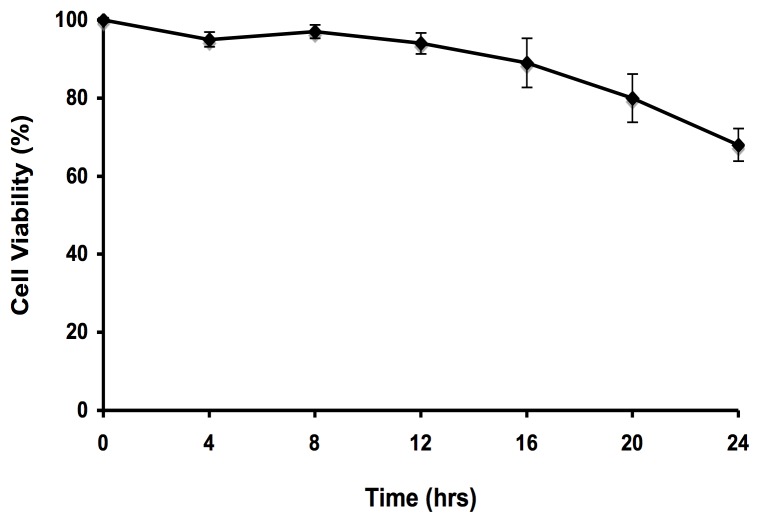
Transcripts altered by iAs exposure.Volcano plots of differential transcripts up- (black dots) and down-regulated (grey dots) after (A) 2 and (B) 12 hrs of exposure to 5 µM of iAs.